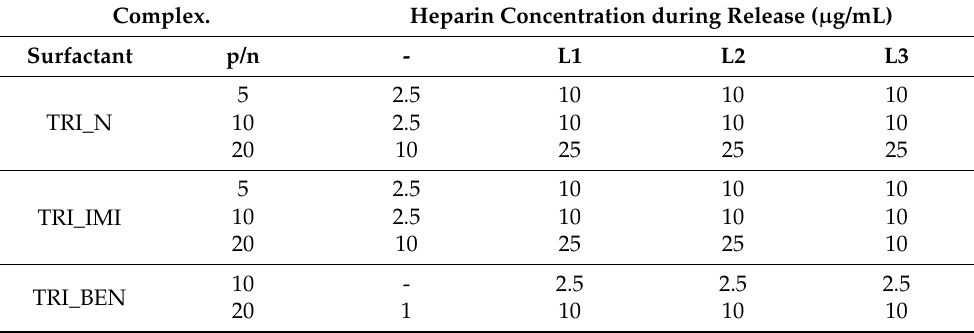
Table 2. Results of heparin induced release of the high-molecular-weight DNA with studied am- phiphilic